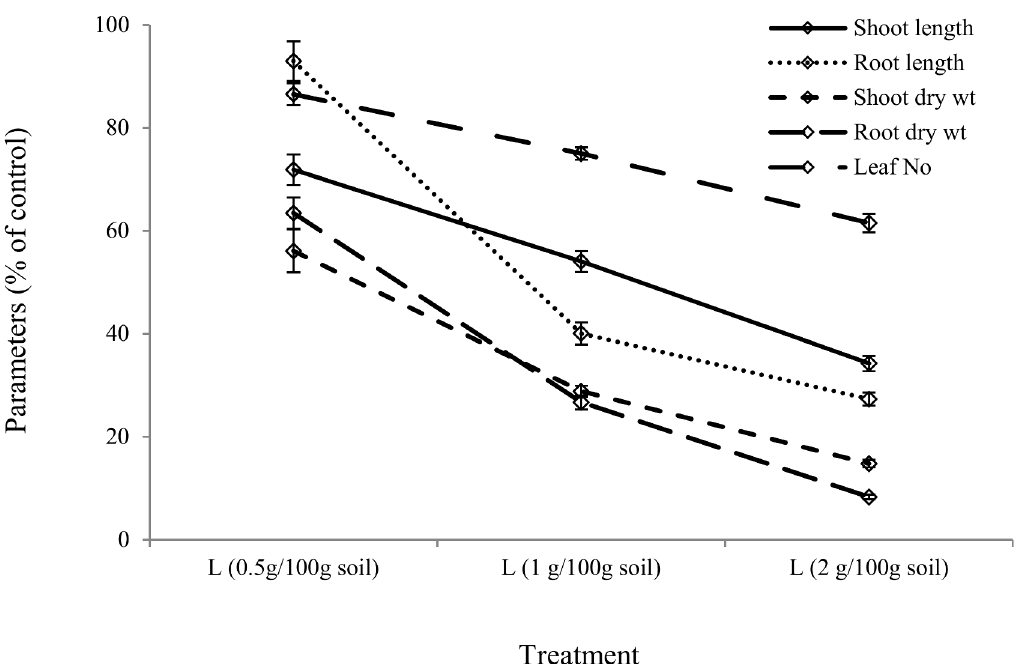
Fig 6. Effect of boneseed litter on biometric parameters of X . bracteatum . The x-axis denotes the doses of litter (L) in g/100gm soil. The y-axis denotes shoot length, root length, shoot dry weight, root dry weight and number of leaf of X . bracteatum (% of control). The error bar indicates the standard error.